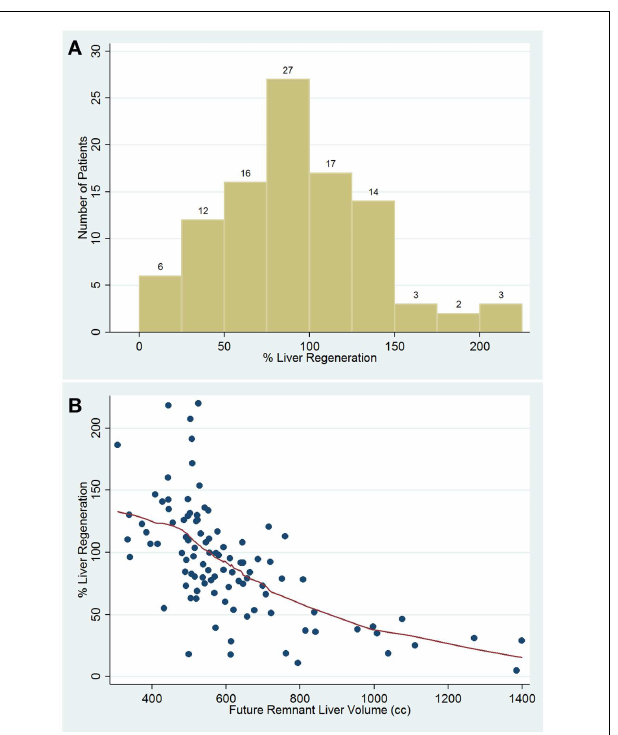
FIGURE 2 | Percentage distribution of liver regeneration rate in cases of control group and in patient with liver malignancies (A) . Scatter plot percentage of liver regeneration compared with future remnant liver volume (B) .